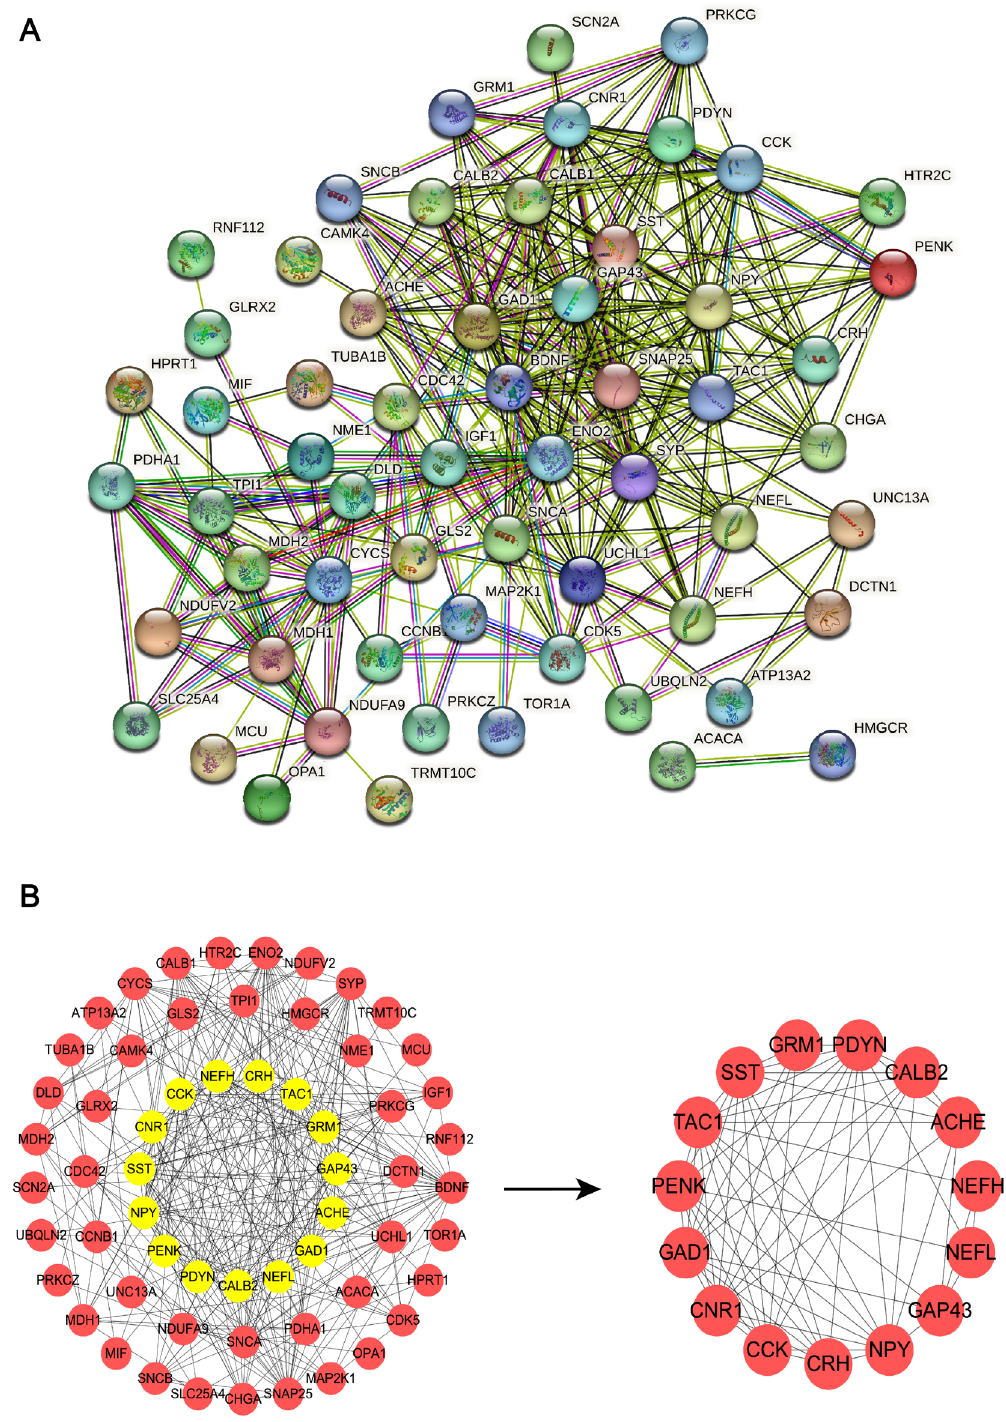
Figure 5. ( A ) PPI network construction for identification of hub genes. ( B ) 15 key modules genes (hub genes) were visualized by PPI